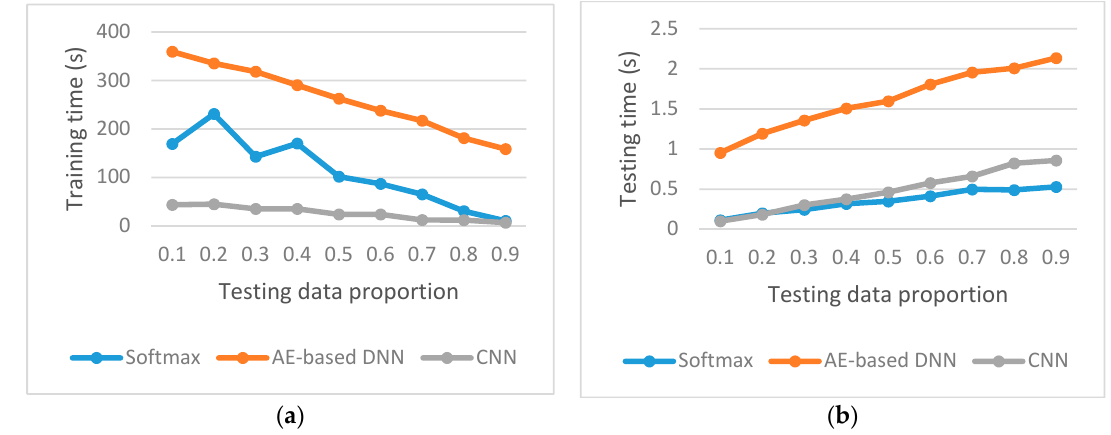
Figure 12. Comparison of speed for the three methods. ( a ) Comparison of training time spent by the three methods, and ( b ) comparison of testing time spent by the three methods.